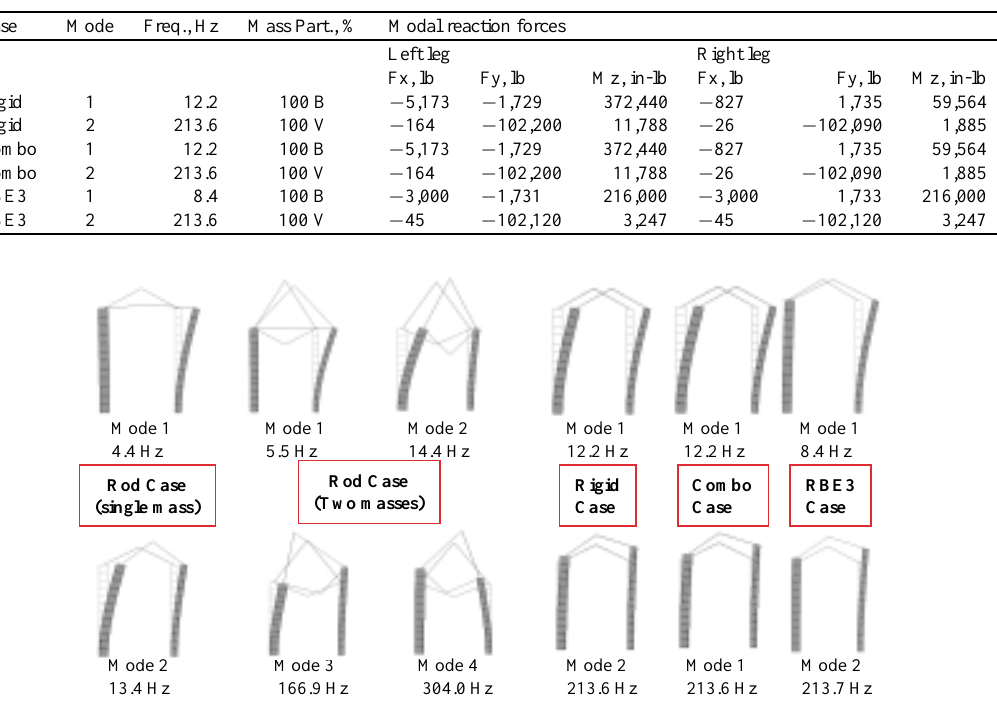
Fig. 12. Mode shapes for asymmetric structure and symmetric